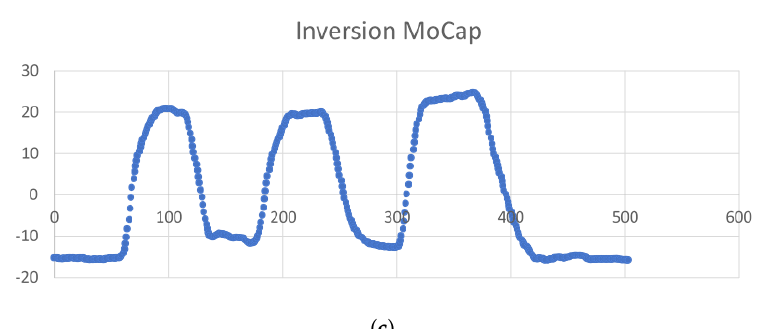
Figure 14. ( a ) Comparison of motion capture and StretchSense when INV movement not performed in isolation. Both datasets scaled to depict relationship between sensing methods. ( b ) Raw motion capture data for PF movement. ( c ) Raw motion capture data for INV movement (positive